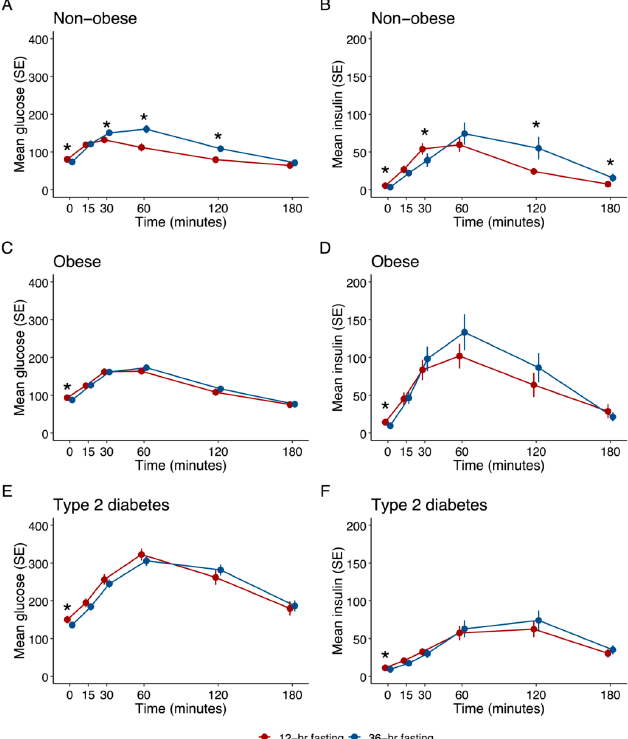
Figure 1. Effects of 12 h and 36 h fasting on glucose metabolism during OGTT (n = 20 in each cohort); * p < 0.05. ( A ) Effect on plasma glucose in non-obese cohort ( B ) Effect on serum insulin in non-obese cohort ( C ) Effect on plasma glucose in obese cohort ( D ) Effect on serum insulin in obese cohort ( E ) Effect on plasma glucose in type 2 diabetes cohort ( F ) Effect on serum insulin in type 2 diabetes cohort.